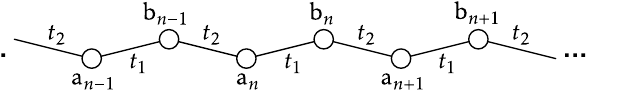
Figure 1. Su-Schrieffer-Heeger model. A unit cell consists of two sites. The hopping rates are set to be t 1 = 1 − λ and t 2 = 1 + λ for 0 ≤ λ ≤